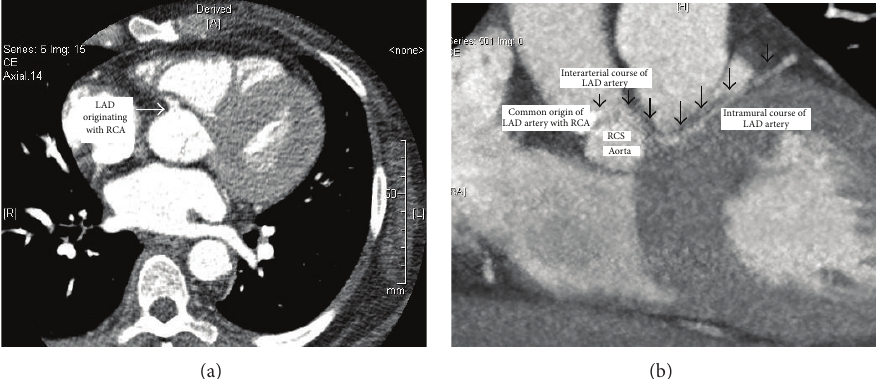
Figure 4: Cardiac coronary CAT scan demonstrating anomalous left coronary artery originating from the right coronary cusp and coursing between aorta and pulmonary artery followed by intramural course. LAD: left anterior descending artery; RCA: right coronary artery.